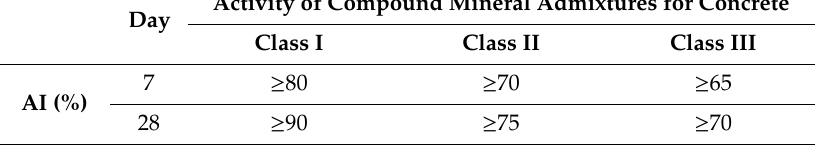
Table 3. Requirement of activity index (AI) values of compound mineral admixtures for concrete according to Chinese standard JG / T486-2015 [13].